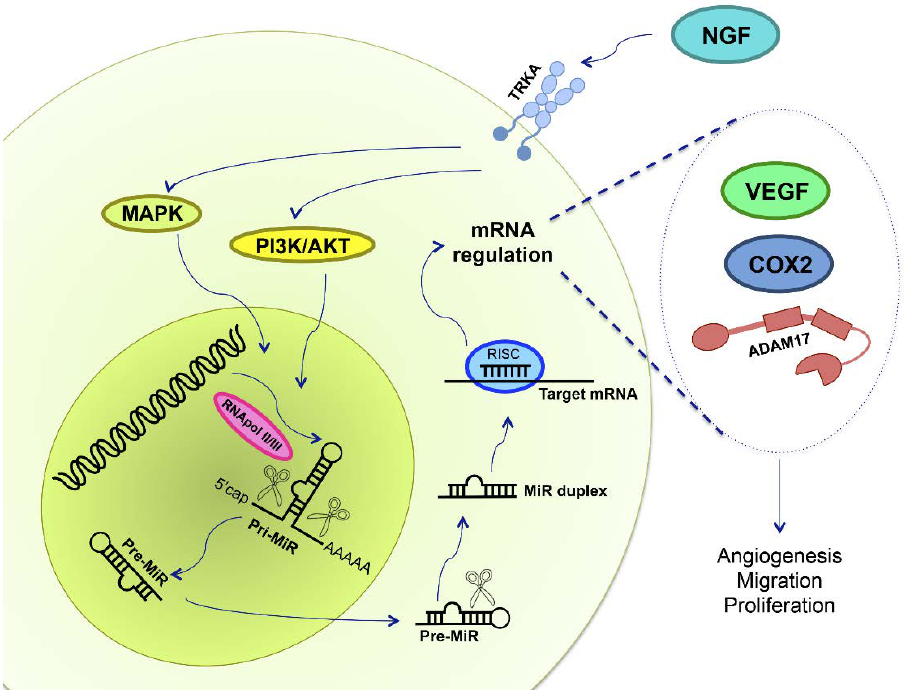
Figure 4. NGF and miRs in epithelial ovarian cancer. NGF binds to its high affinity receptor TRKA, activating MAPK and PI3K/AKT signaling pathways. Deregulation in miR expression has been reported in EOC, and NGF could regulate primary-miR (pri-MiR) synthesis. RNApol II/III synthesizes miRs, and afterwards proteins cleave both pri-miR and precursor miRs (pre-miR), in the nucleus and in the cytoplasm, respectively, leading to miR maturation. mRNA repression is done by RNA-silencing inducing complex (RISC), a multiprotein complex, and by the mature miR, regulating mRNA expression through its degradation, deadenilation or inhibiting its translation. Therefore, we hypothesized that NGF/TRKA modifies miR expression in order to regulate VEGF, COX2 and ADAM17 protein levels. An increase of VEGF, COX2 and ADAM17 are related with changes in angiogenesis, migration and proliferation, processes needed for EOC development.